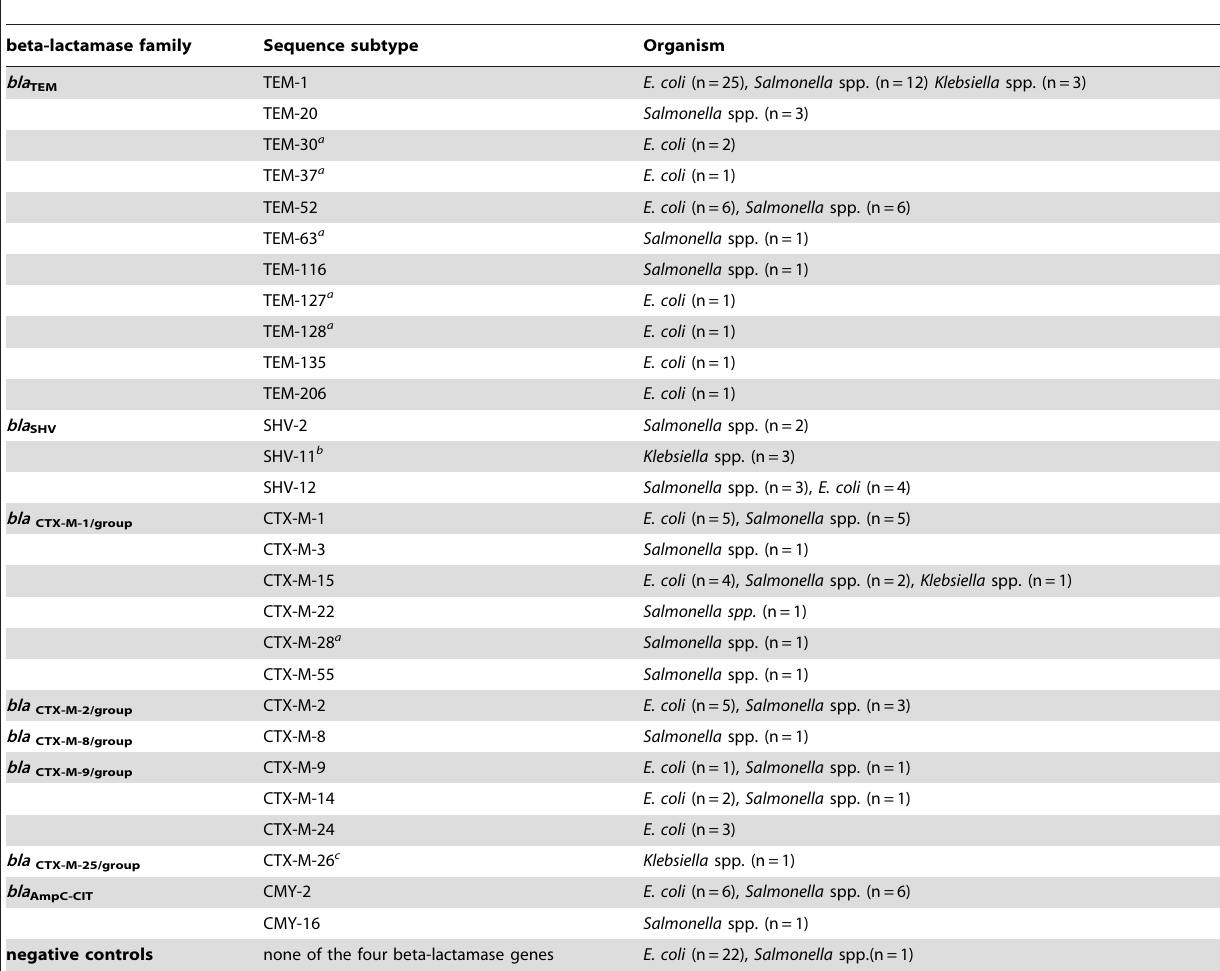
Table 1. Overview of the class A and class C beta-lactamase gene subtypes present within the 114 bacterial isolates used for the assay